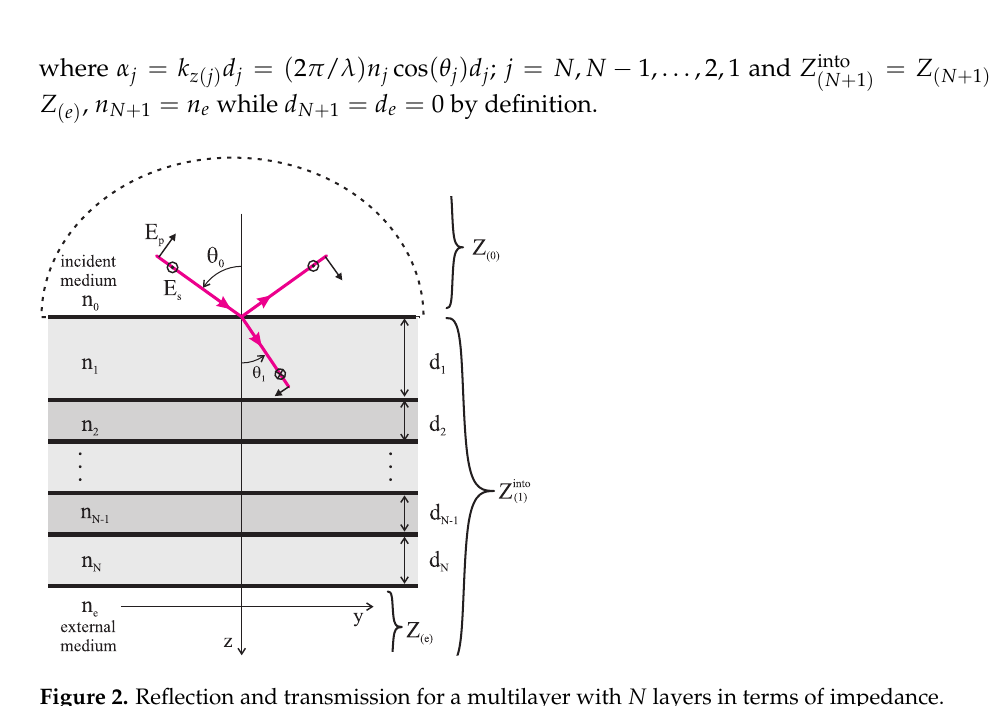
Figure 2. Reflection and transmission for a multilayer with N layers in terms of